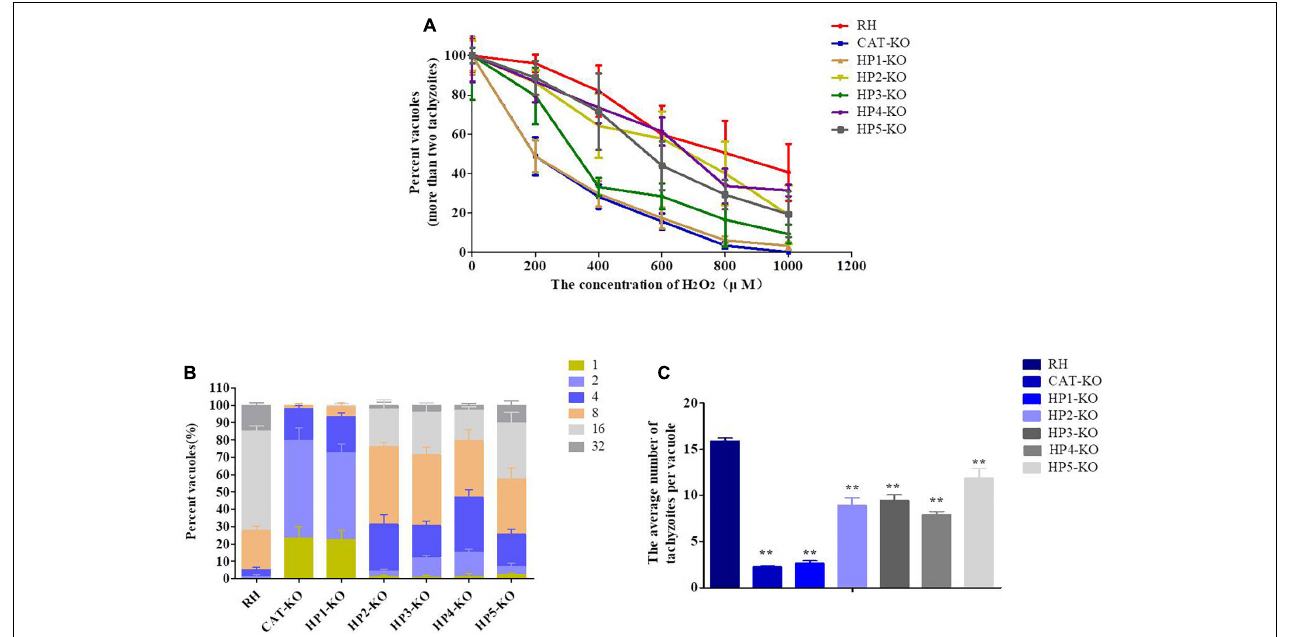
FIGURE 3 | Effect of H 2 O 2 on knockout parasites and RH strain. (A) Effect of H 2 O 2 on the viability of T. gondii parental and knockout strains. Fresh tachyzoites of different strains were incubated for 30 min in the presence of the indicated H 2 O 2 concentrations. The treated parasites were inoculated on Vero cells. The number of vacuoles was counted under a microscope at 36 h after infection. Data are expressed as a percentage (%) of the number of vacuoles formed by the treated groups compared to the untreated group. (B,C) At 12 h post-infection with tachyzoites, the cells were cultured in a medium containing 200 µ M H 2 O 2 . The effect of H 2 O 2 on parasite replication was assessed by calculating the number of tachyzoites in each vacuole after 36 h of infection for a minimum of 100 vacuoles per strain. (B) Data are expressed as the percentage of vacuoles containing 1, 2, 4, 8, 16, and 32 parasites. (C) Data are expressed as the average number of parasites per vacuole. Data are represented as the mean ± standard deviation ( n = 4). ** P < 0.01, * P < 0.05, significant changes versus controls.